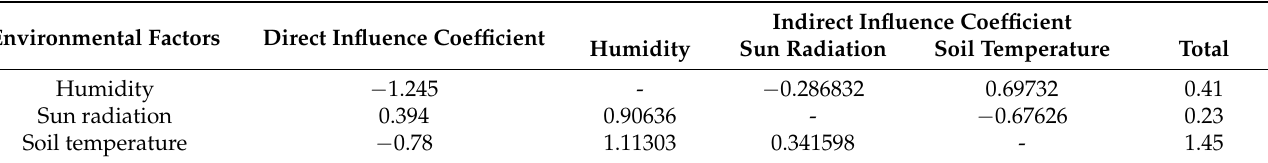
Table 10. Path analysis of the mercury flux and environmental factors during the reproductive stages of Setaria . Environmental